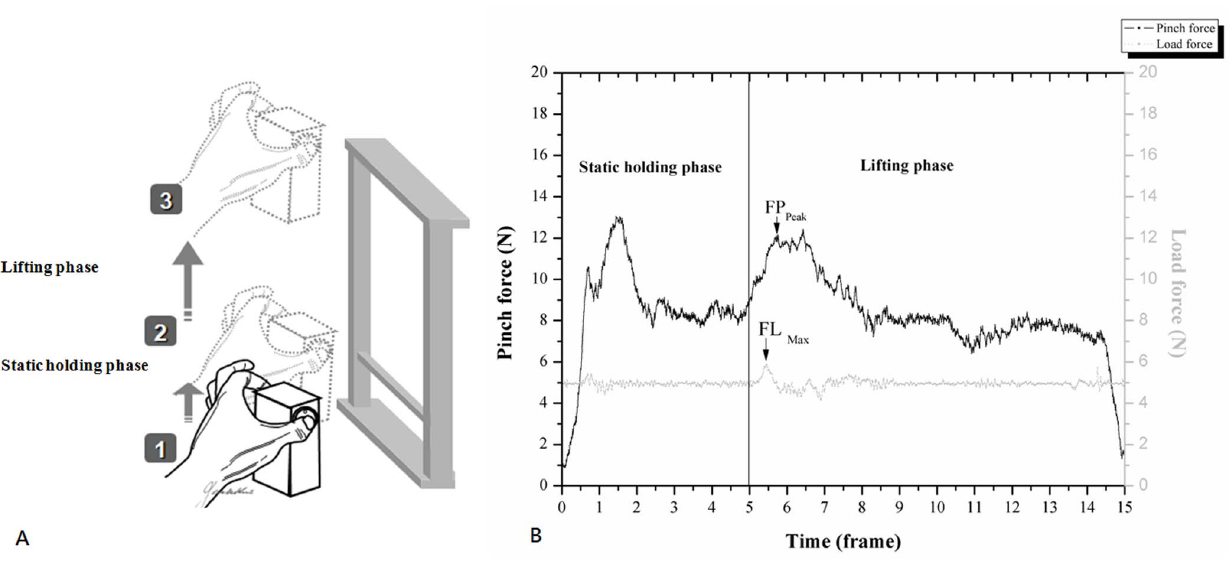
Figure 1. The experimental procedures and data analysis of this study. (A): Schematic representation of the pinch-holding-up activity. (B): Data analysis of a functional sensibility test.